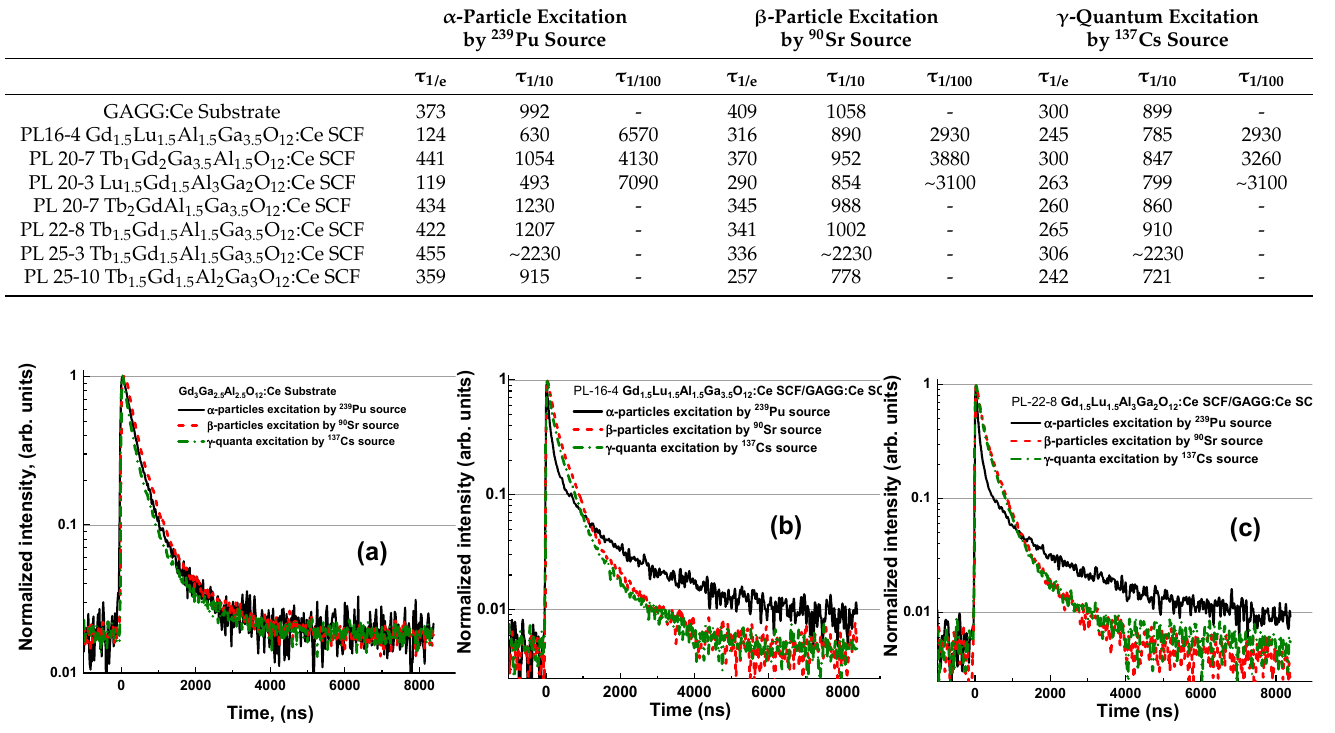
Figure 9. Scintillation decay of GAGG:Ce SC substrate ( a ) and Lu 1.5 Gd 1.5 Al 1.5 Ga 3.5 O 12 :Ce SCF/GAGG:Ce SC composite scintillators grown from PbO- ( b ) and BaO-based ( c ) fluxes under α - and β -particle and γ -ray excitations.